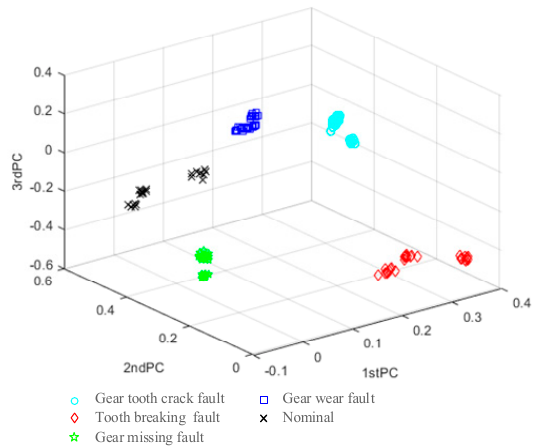
Figure 20. Clustering result of wavelet entropy under variable conditions.